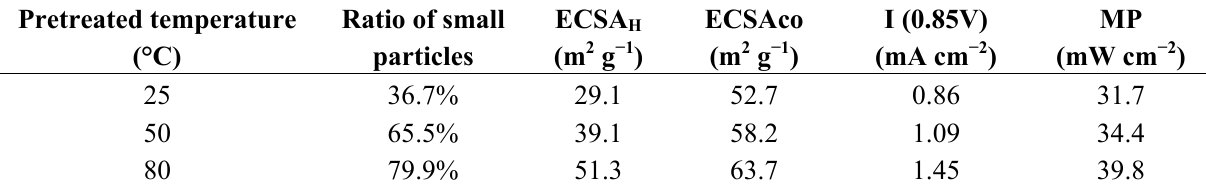
Table 3. Particle size distributions and electrochemical characterizations of Pt/C electrode with catalyst ink pretreated at different